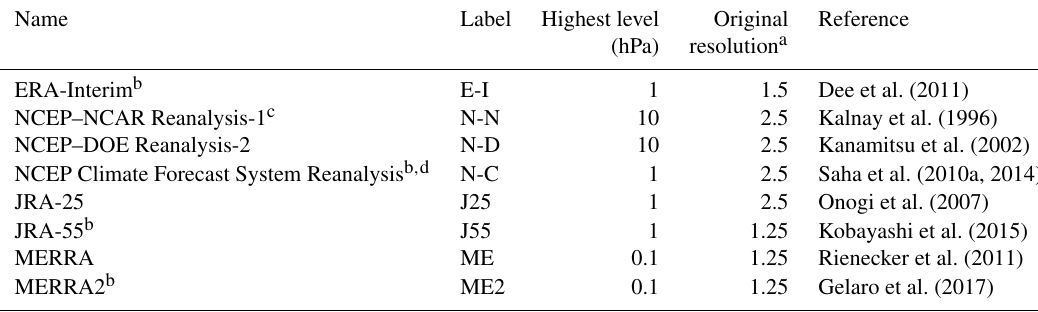
Table 1. Summary of reanalysis datasets included in the comparison.